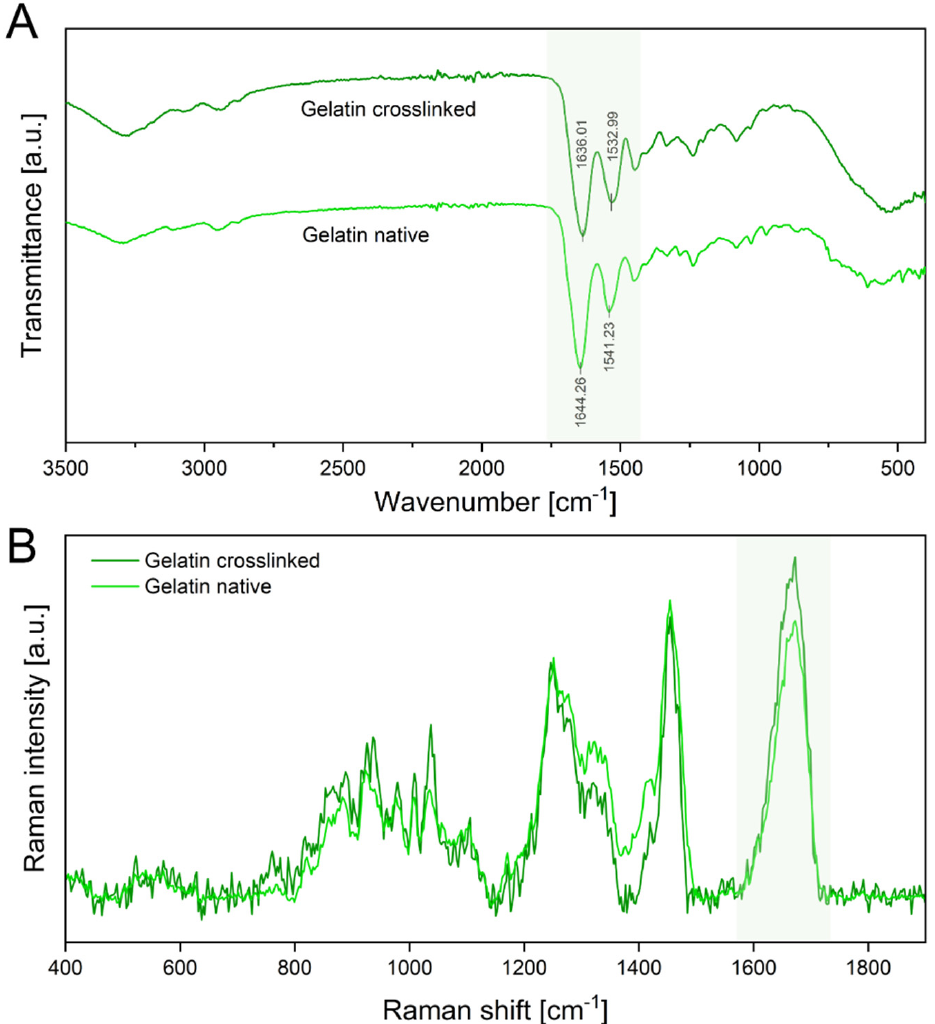
Figure 4. ( A ) ATR-IR spectra of the crosslinked electrospun gelatin fibers and native gelatin fibers. The amide I and amide II peaks are highlighted in green. ( B ) Raman spectra of native and crosslinked gelatin show a distinct C=N stretching vibration at 1664 cm − 1 of the amide I region, also high- lighted green.